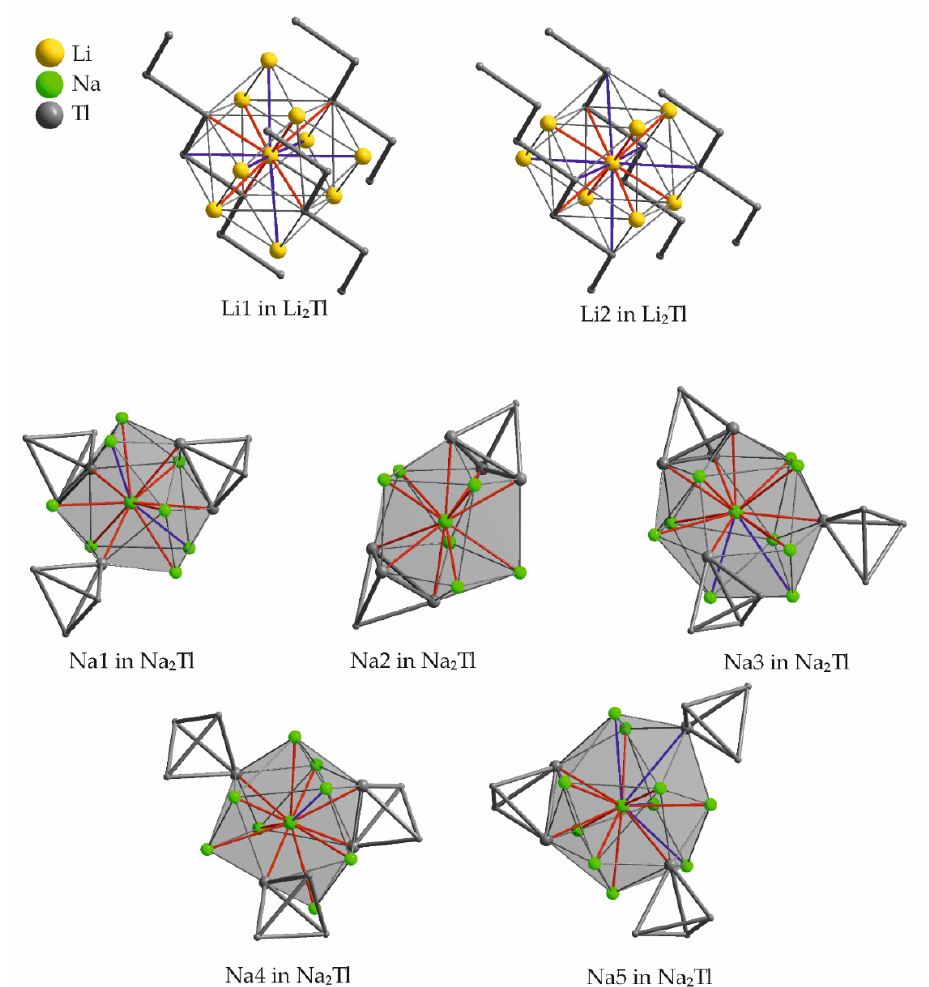
Figure 13. Atomic environment of the symmetry inequivalent alkali metals in Na 2 Tl. The corresponding range of distances to the adjacent atoms as well as the Wyckoff letters are given in Table 15. Shorter contacts are colored red, longer distances are given in blue.